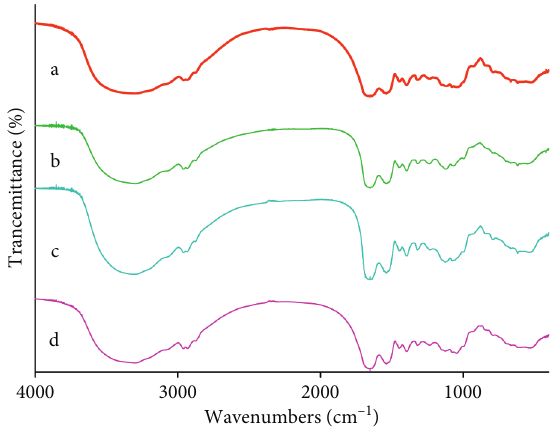
Figure 5: The FTIR spectra of PNMP extracts from (a) ultrasonic extraction method, (b) microwave extraction method, (c) hot water extraction method, and (d) homogenate extraction